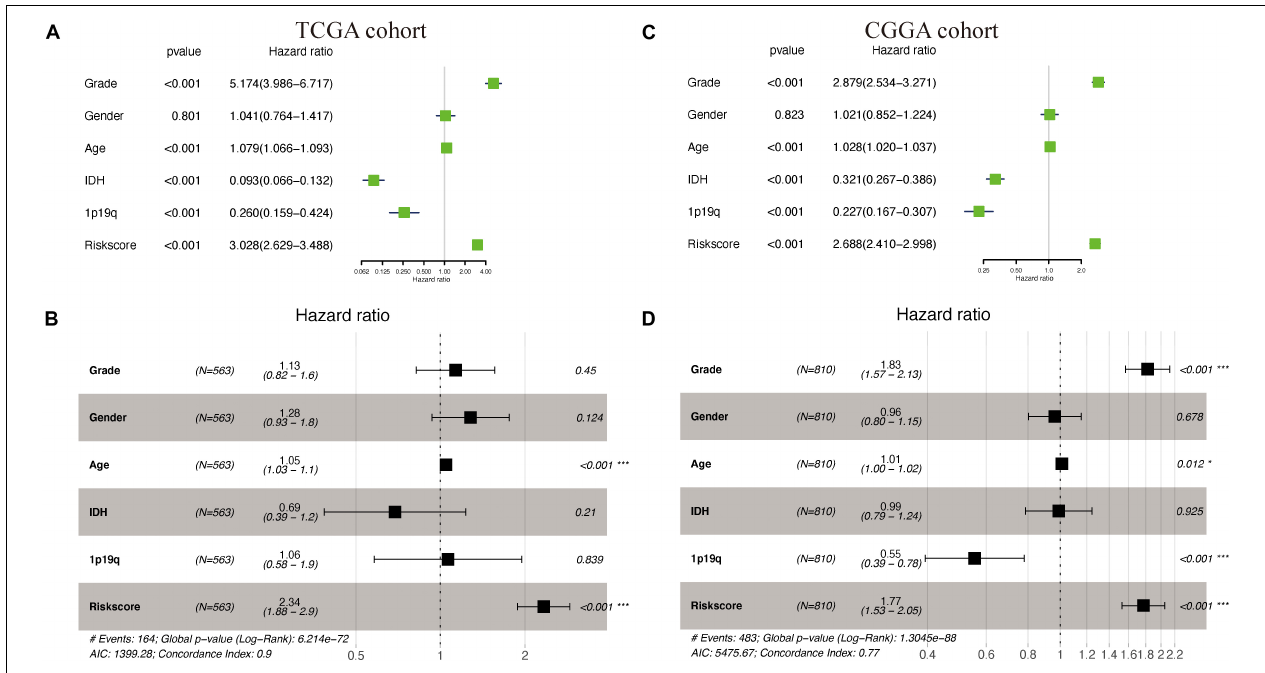
FIGURE 6 | Cox regression analyses in The Cancer Genome Atlas (TCGA) and the Chinese Glioma Genome Atlas (CGGA) cohorts. (A,B) Univariate and multivariate Cox regression analyses of risk score and pathologic characteristics in TCGA cohort. (C,D) Univariate and multivariate Cox regression analyses of risk score and pathologic characteristics in the CGGA